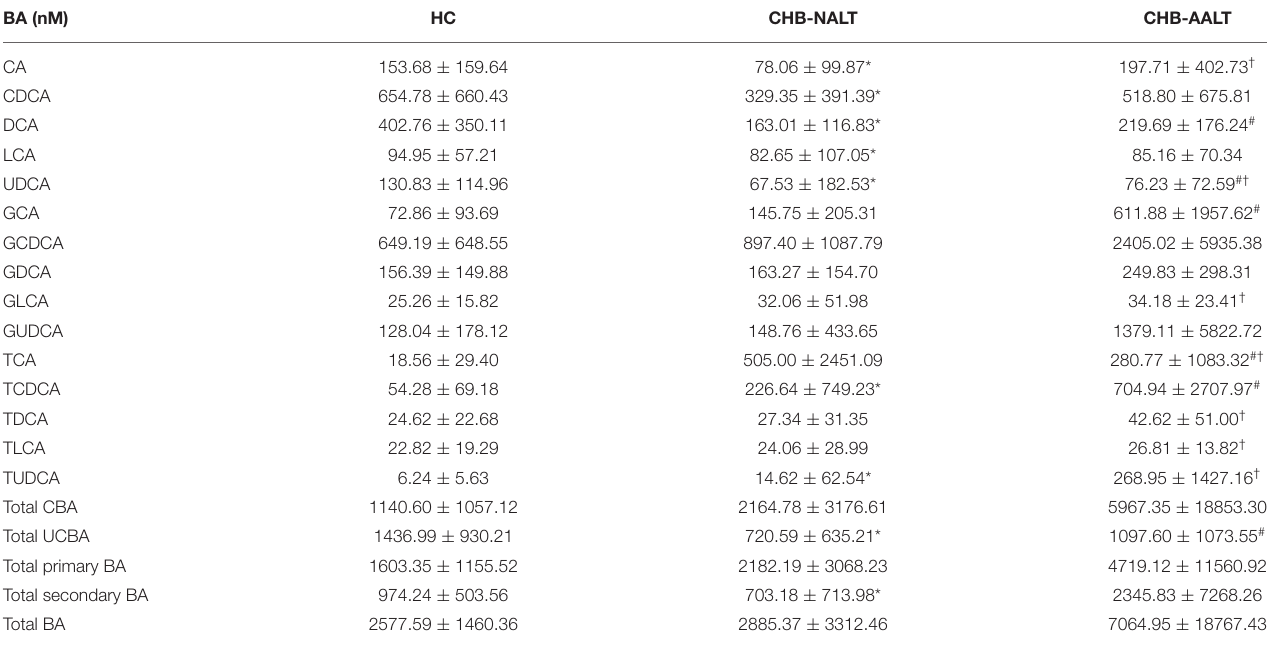
Tablerepresentthemean ± SEM.HC,healthycontrolgroup;CHB-NALT,ALTnormalpatientgroup;CHB-AALT,ALTabnormalpatientgroup.PvaluesweredeterminedbyMann–Whitney U test, significant difference (P < 0.05) between HC and CHB-NALT * , HC and CHB-AALT # or between CHB-NALT and CHB-AALT † were indicated, respectively.